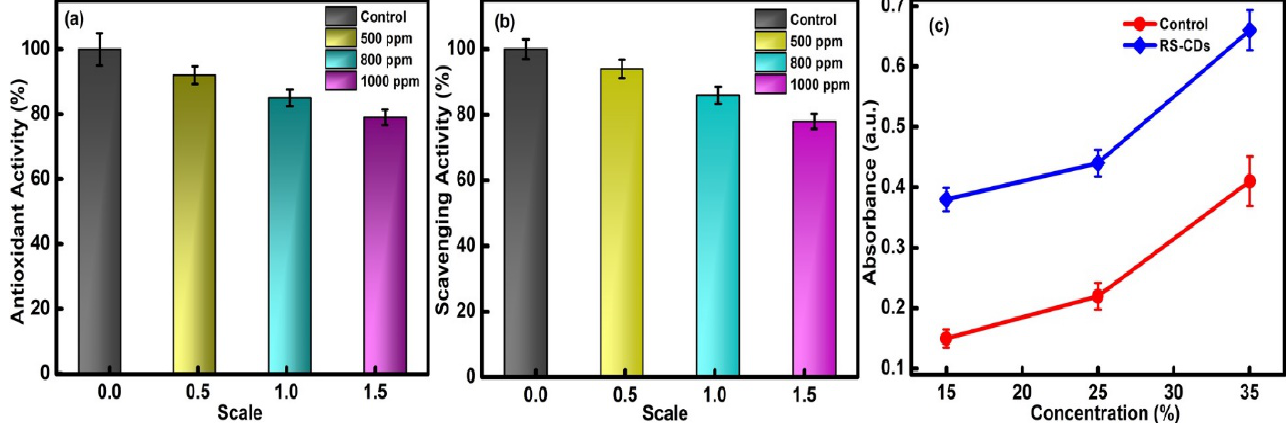
Figure 6. Effect of various concentrations of CQDs on ( a ) anti-oxidant activity, ( b ) hydrogen peroxide free radical scavenging assay and ( c ) total reduction capacity.